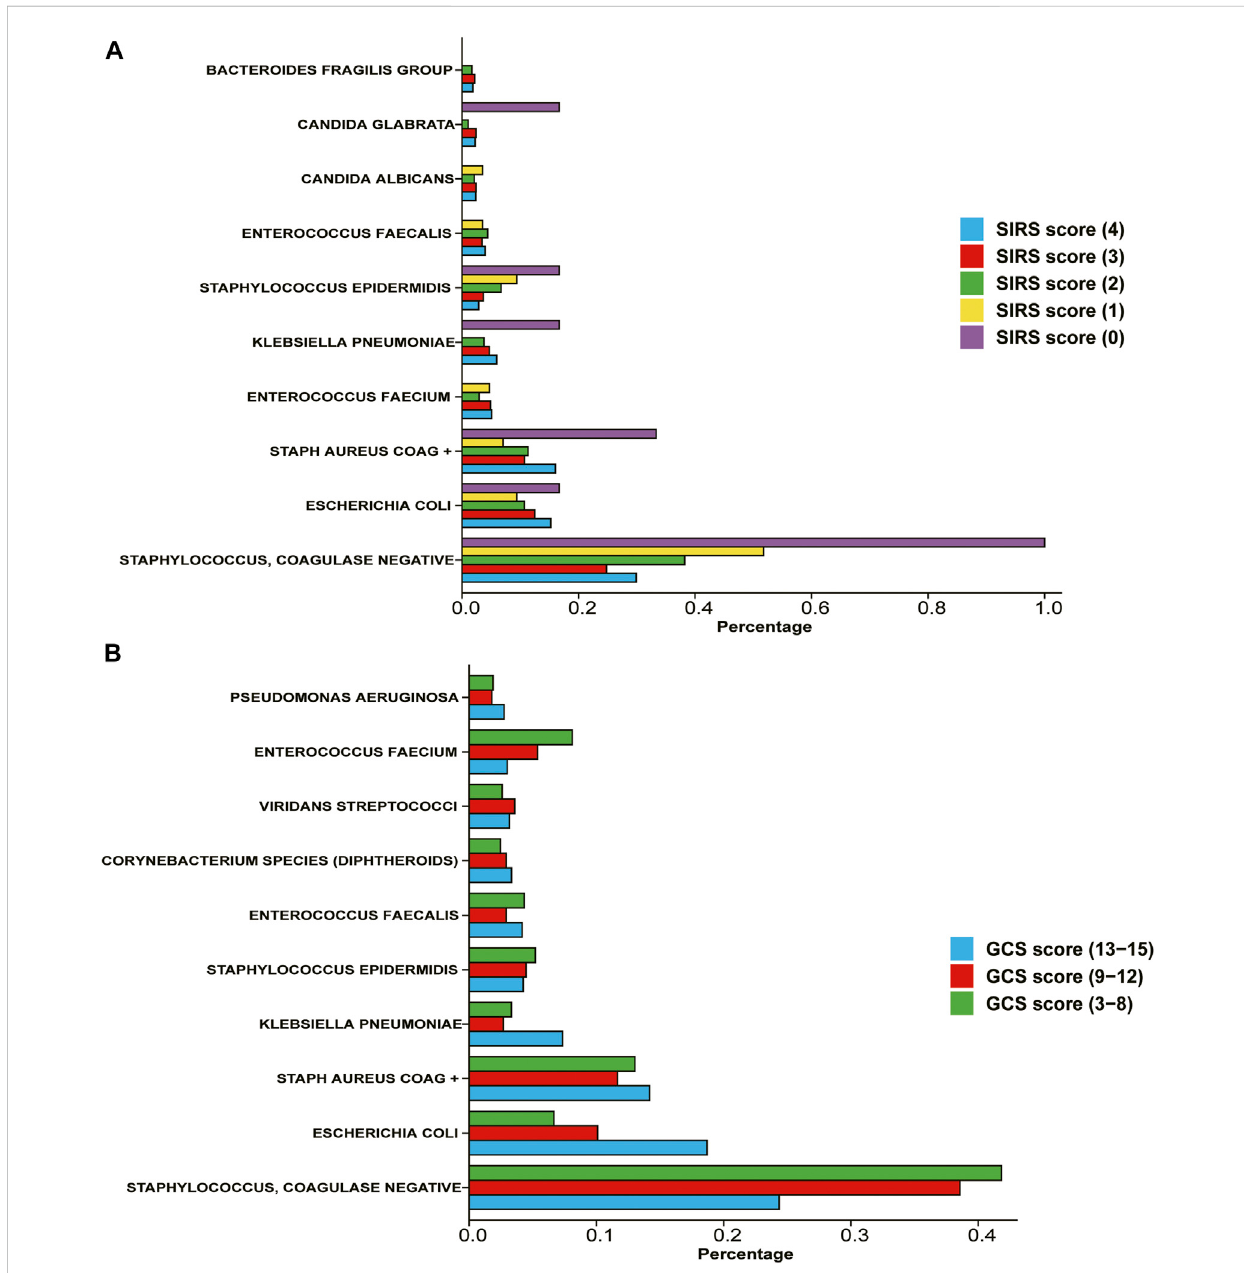
FIGURE 2 Percentage of differenttypesof bacteria in patients with different severity (A) Divide thepopulation according to the SIRS score on the fi rst day after admission to the ICU. (B) Divide the population according to the GCS score on the fi rst day after admission to the ICU.